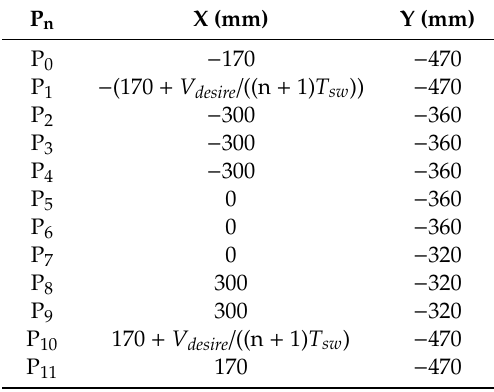
Table 2. The 12-control point of B é zier